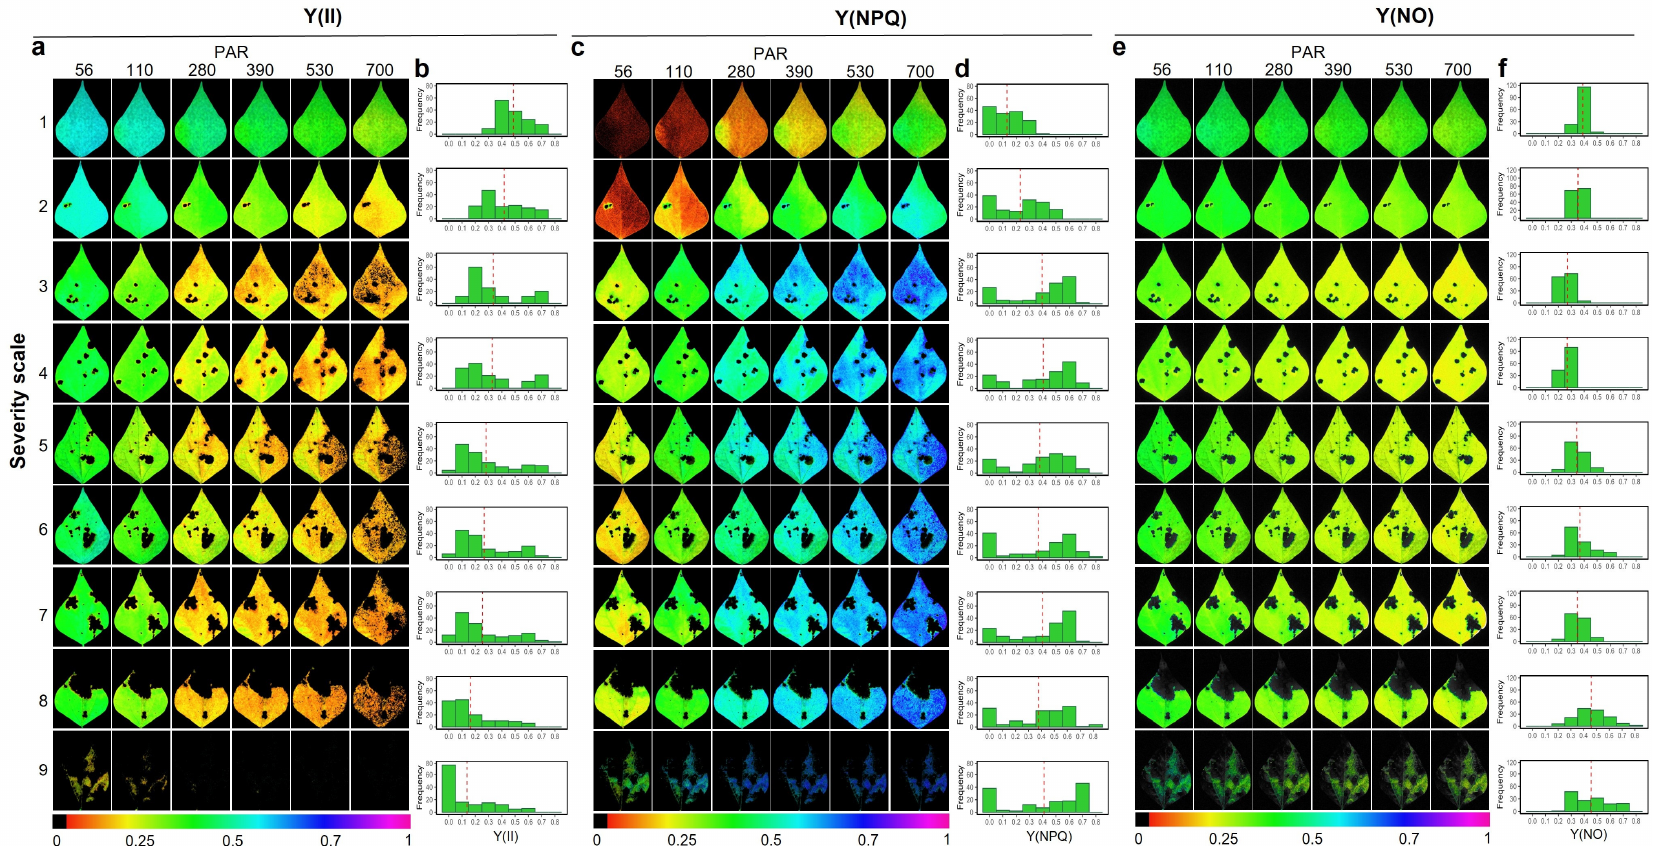
Figure 3. Energy allocation processes with an increase in photosynthetically active radiation (PAR) as a function of the increase in the degree of affected leaf area caused by Web blight and measured in different severity scales in common bean leaf blades. Results are shown as ( a ) images of the effective quantum yield in the PSII photosystem Y(II); ( b ) histograms of absolute frequencies of Y(II); ( c ). images of the quantum yield of the regulated energy dissipation Y(NPQ); ( d ) histograms of absolute frequencies of Y(NPQ), ( e ) images of the quantum yield of the unregulated energy dissipation Y(NO); and ( f ) histograms of absolute frequencies of Y(NO). Absolute frequency histograms correspond to 12 AOI (area of interest). The color gradient from violet to red or black indicates the maximum and minimum value of each variable, respectively, where healthy zones range from blue to violet, and affected zones range from green to black.